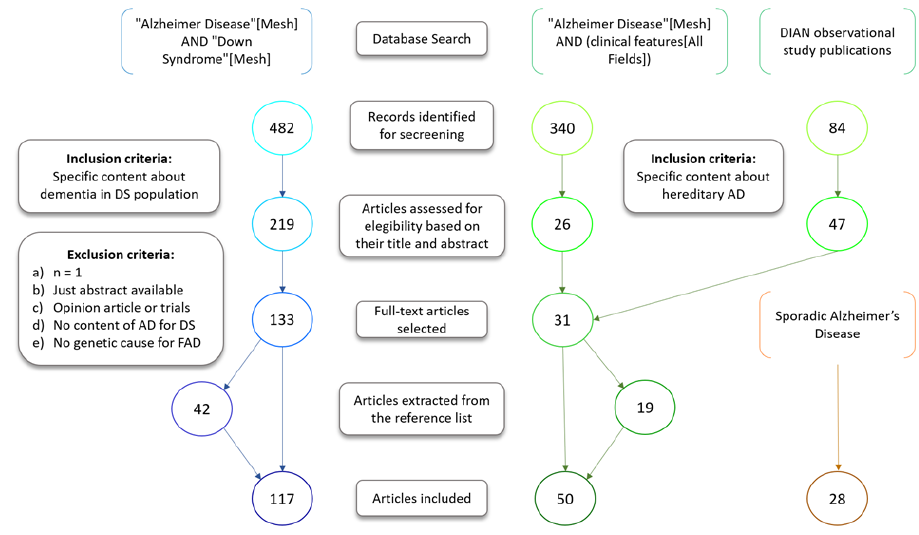
Figure 1. Search methodology undertaken for the review. AD, Alzheimer’s Disease; DS, Down syndrome-associated; FAD (Familial Alzheimer’s Disease), DIAN, the Dominantly Inherited Alzheimer Network.